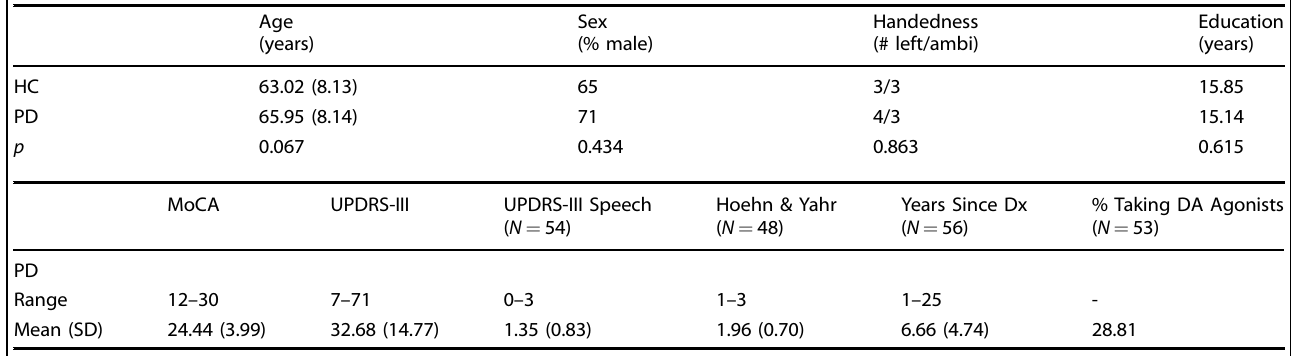
Table 1. Between-group demographic comparisons and patient group clinical pro fi